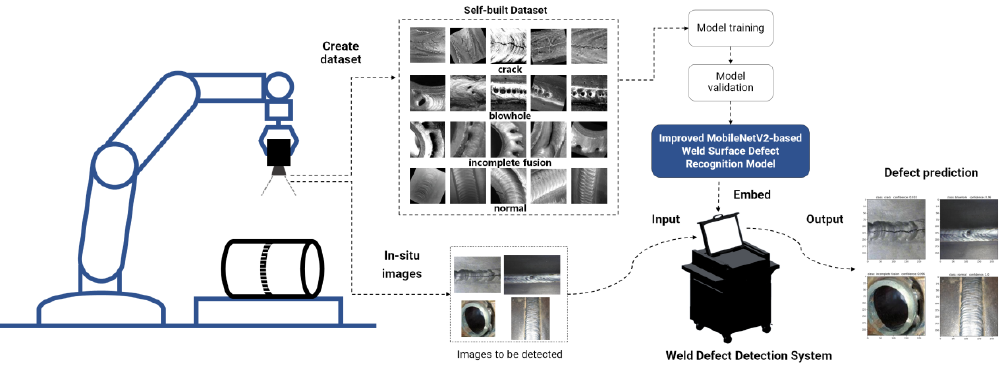
Figure 8. Industrial scenario of weld surface defect recognition.